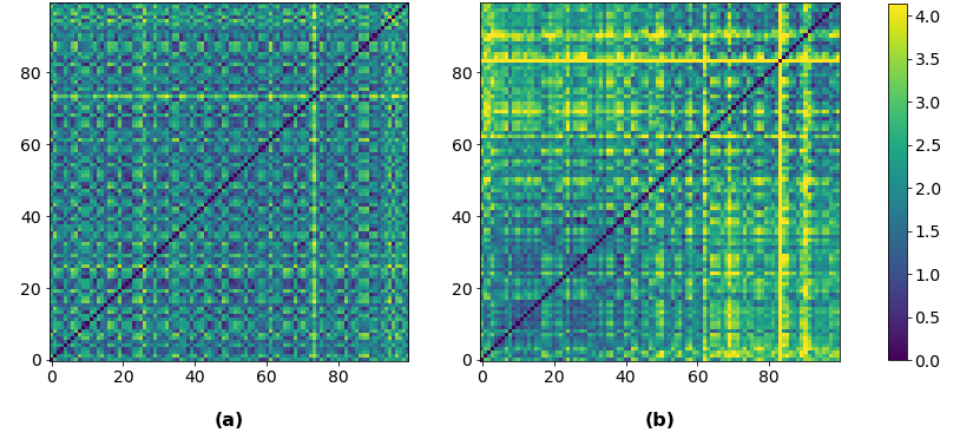
Figure 24. Distance plots for CNN feature extraction, with a window length of 100 time steps: ( a ) NOC state; and ( b ) overloaded mill state.